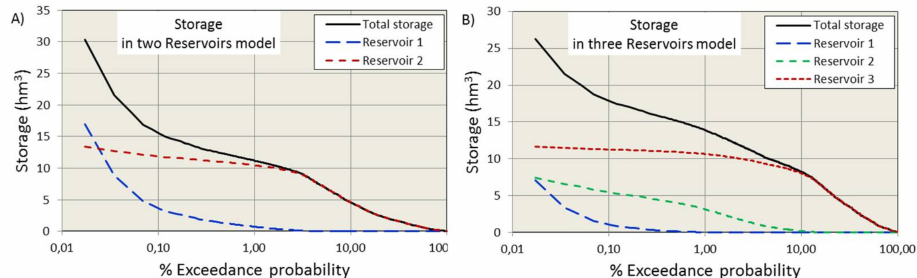
Figure 9. Storage duration curves (SDCs) for the 2R and 3R models. The storage represents the availability of water resources in the catchment; ( A ) storage in two reservoirs model; ( B ) storage in three reservoirs